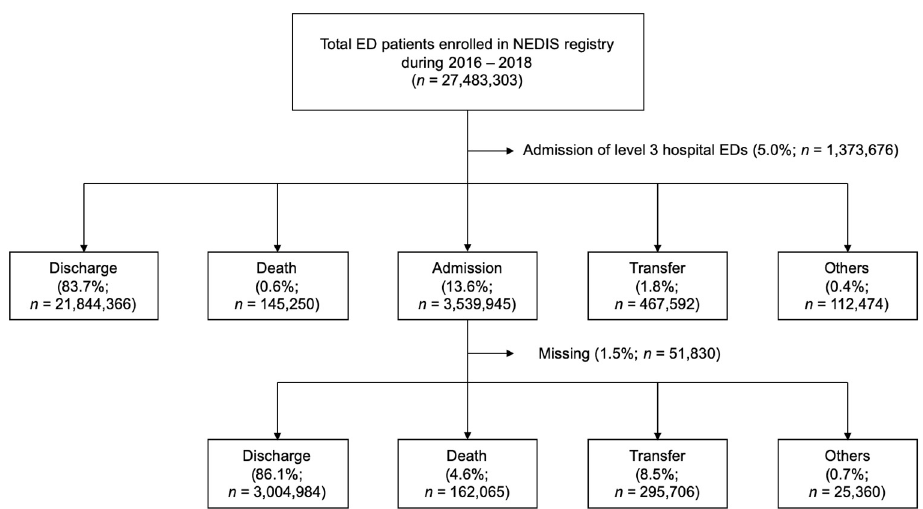
Figure 1. Study flowchart. ED, emergency department; NEDIS, National Emergency Department Information System.